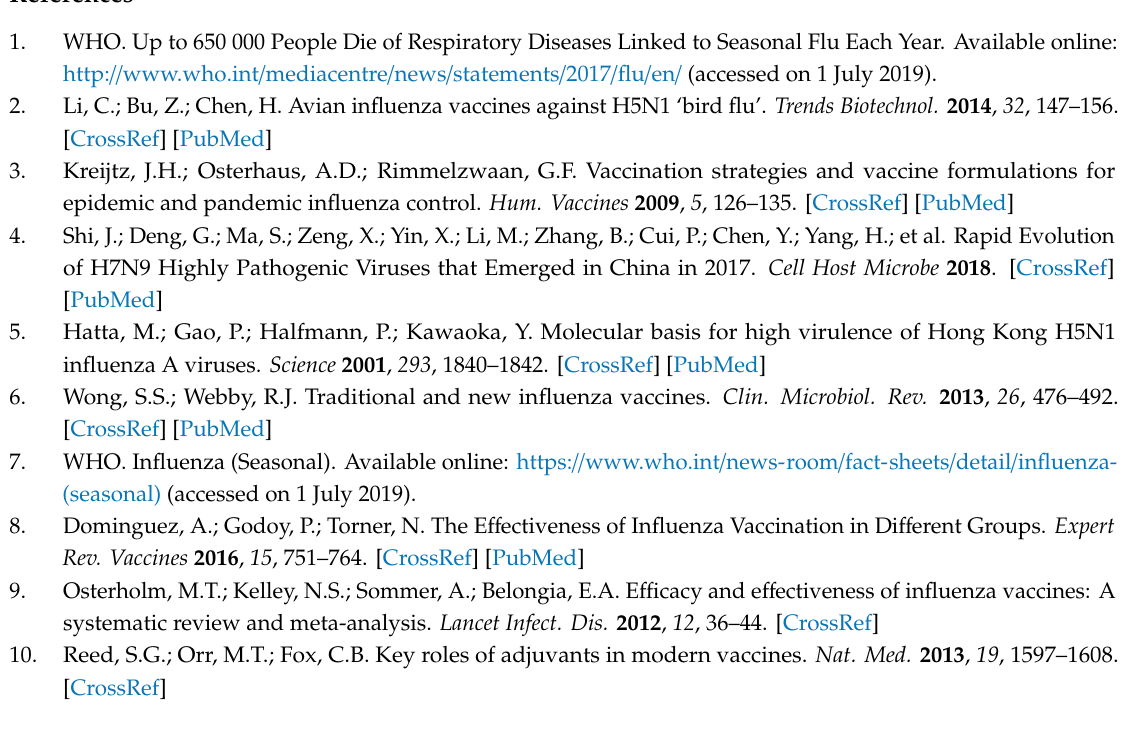
Figure S1: Determination of the appropriate antigen dose for the primary screen; Figure S2: Body weight changes and survival rates of immunized mice after lethal challenge (33 hit compounds); Table S1: The properties, antibody titers, and status of the food additives used in this study (Excel file); Table S2: The protective e ffi cacy generated by immunization with each of 59 hit compounds and HA vaccine in mice (Excel